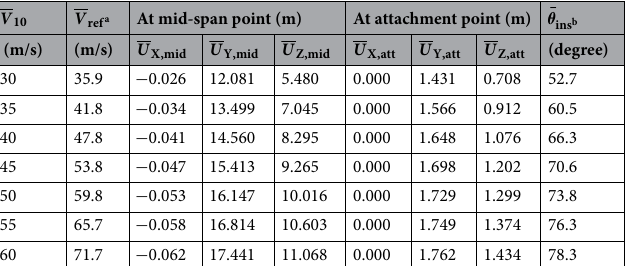
Table 1. Displacements under mean wind load. a Mean wind velocity at the reference height ( angle of the suspension insulator string,